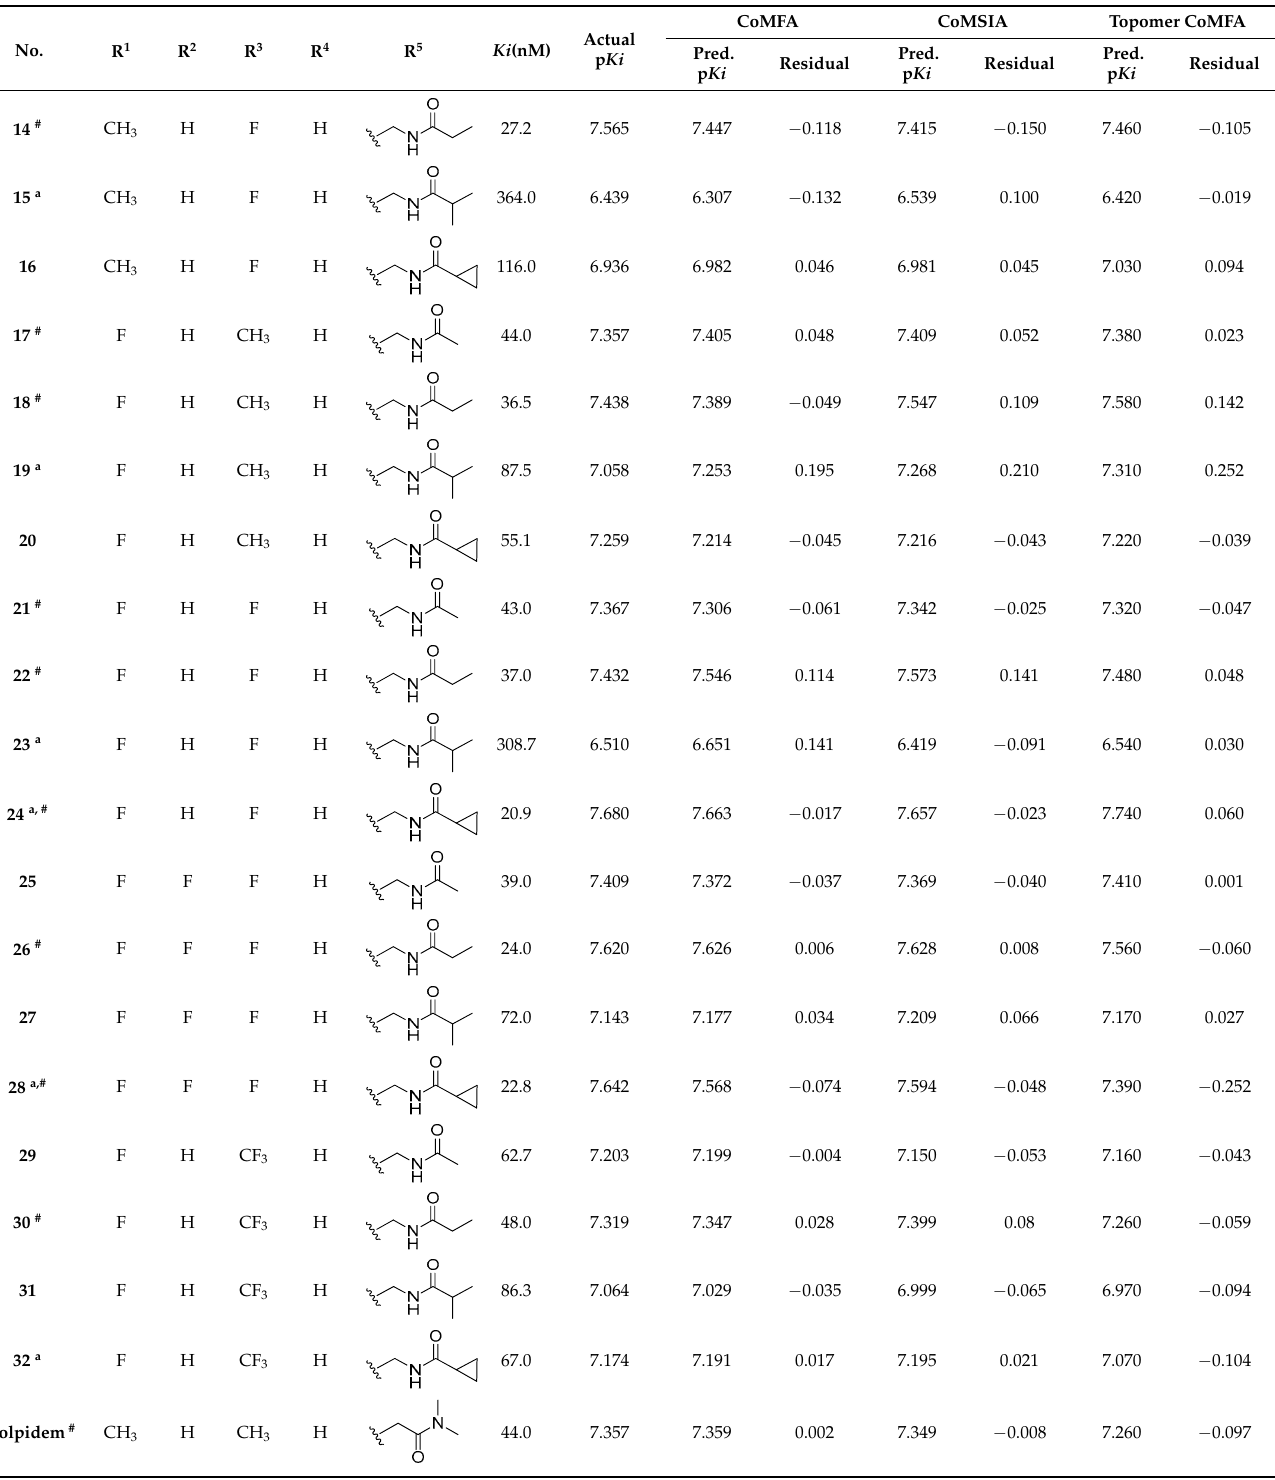
Table 1. Chemical structures of the used imidazo [1,2-a]-pyridine derivatives and their actual and predicted p Ki values.